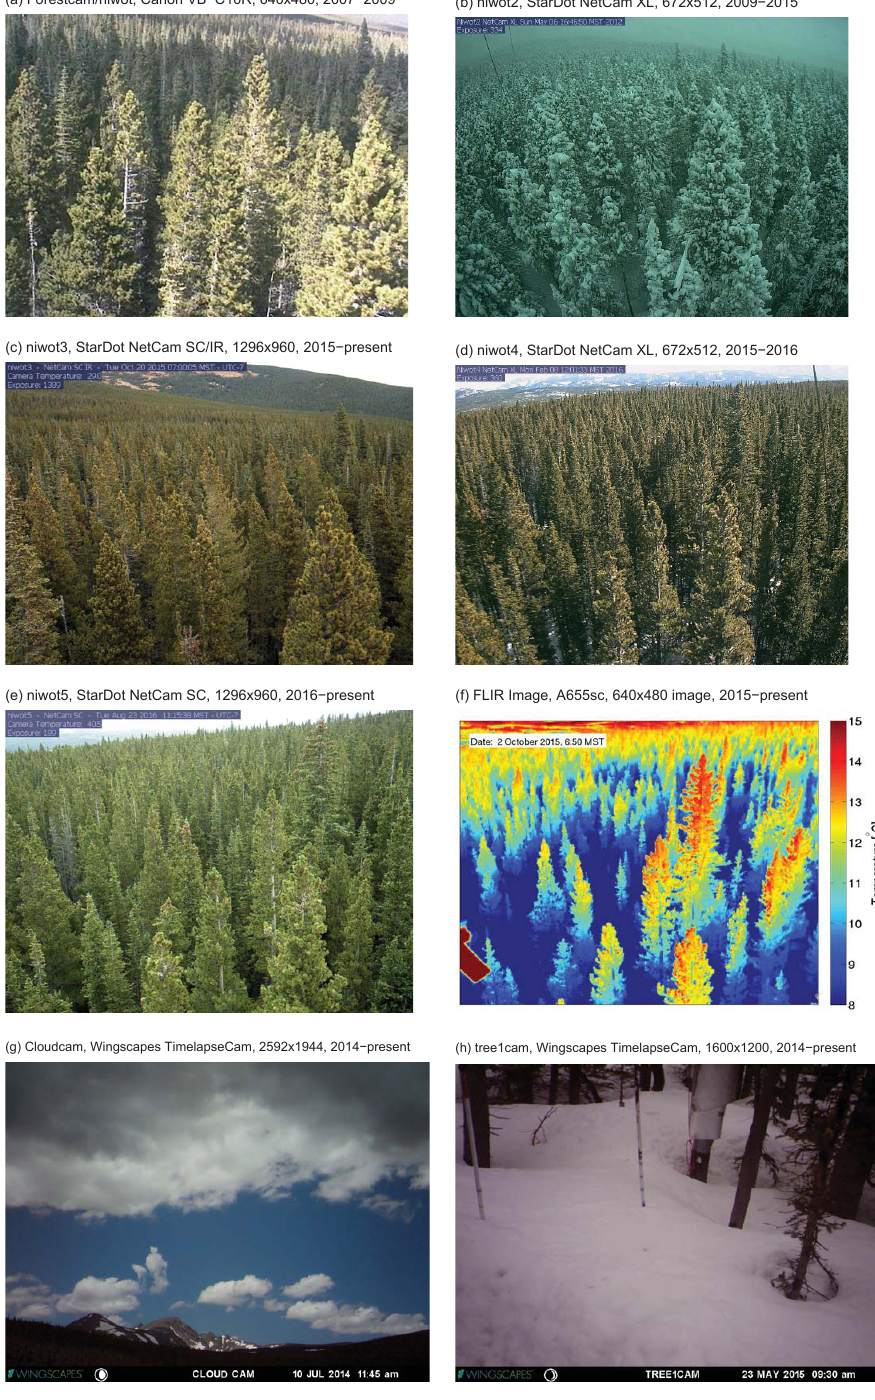
Figure 6. Example photos from different webcams installed on the US-NR1 tower. The camera name, camera type, raw image size, and dates of operation are provided above each photo. Cameras niwot, niwot2, niwot3, and tree1cam are all pointed north; niwot4, niwot5, and FLIR are looking east/northeast; and the cloudcam is looking west. The cameras niwot2 and niwot4 are the same physical camera. Images from niwot, niwot2, niwot3, niwot4, and niwot5 are all available from the University of New Hampshire PhenoCam project website (http://phenocam.sr.unh.edu/). The emissivity-corrected FLIR image was captured on the morning of 2 October 2015 as the upper canopy was warming up. The cloudcam and tree1cam cameras were not capturing images for the entire period